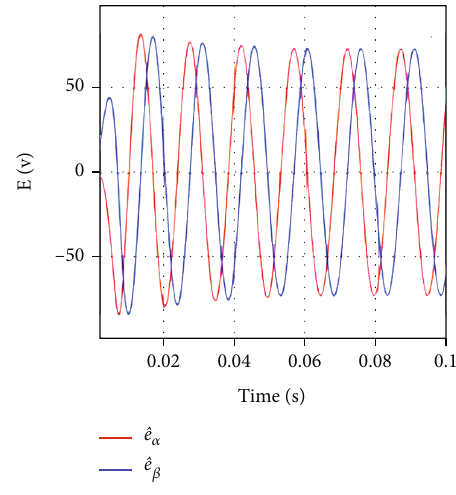
Figure 12: BEMF waveforms using the